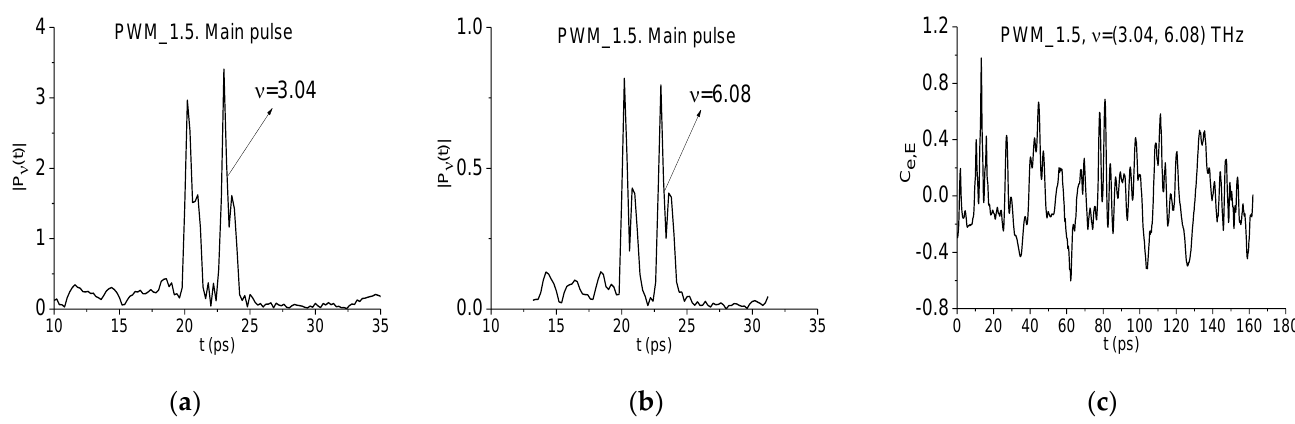
Figure 19. Time-dependent evolution of the PWM_1.5 intensity at the frequencies ν = 3.04 THz ( a ) and 6.08 THz ( b ) in the time interval t = [10, 35] ps. Correlation coefficient c e , E ( t n ) between the PWM_1.5 dynamics for the frequency pair ν = (3.04, 6.08) THz ( c ).